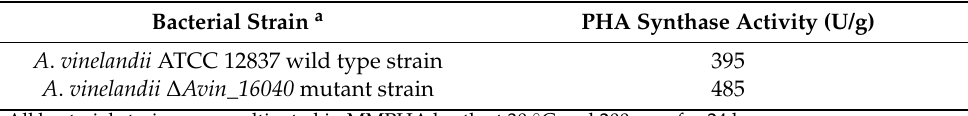
Table 2. PHA synthase activities of both A . vinelandii ATCC 12837 and ∆ Avin_16040 mutant